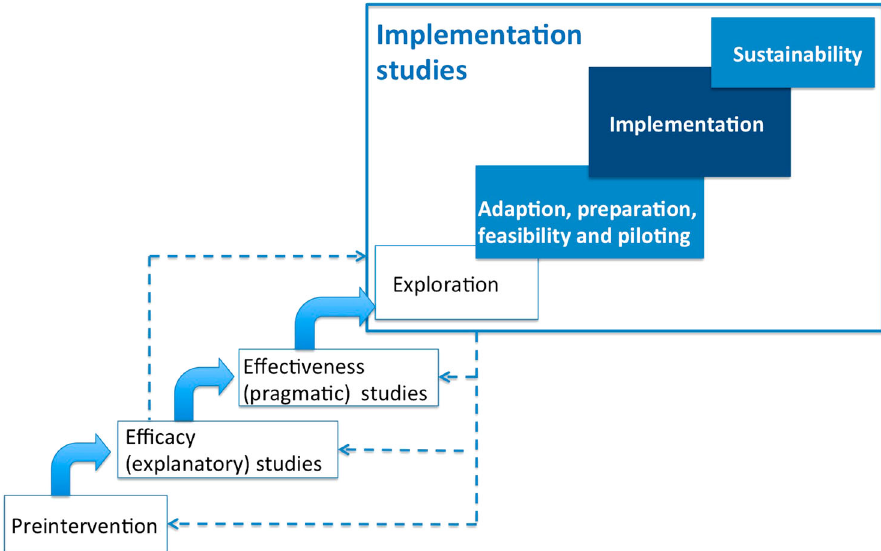
Fig. 1 Positioning of implementation studies and the focus of StaRI reporting standards (reproduced with permission from Pinnock et al. [25]). StaRI is targeted on the reporting of interventional implementation studies (the dark shaded box ) but will have resonance for studies in the pilot and sustainability